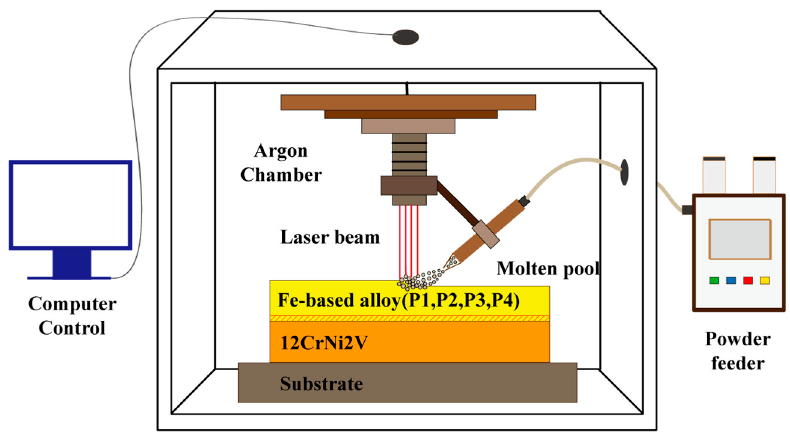
Figure 2. Schematic diagram of laser melting deposition process.